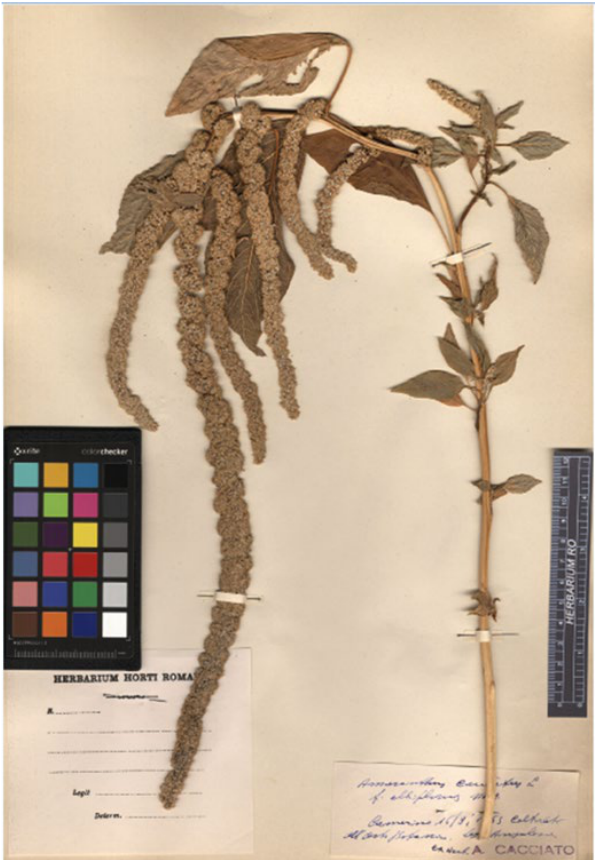
Figure 4. Neotype of the name Amaranthus caudatus var. albiflorus (RO!).